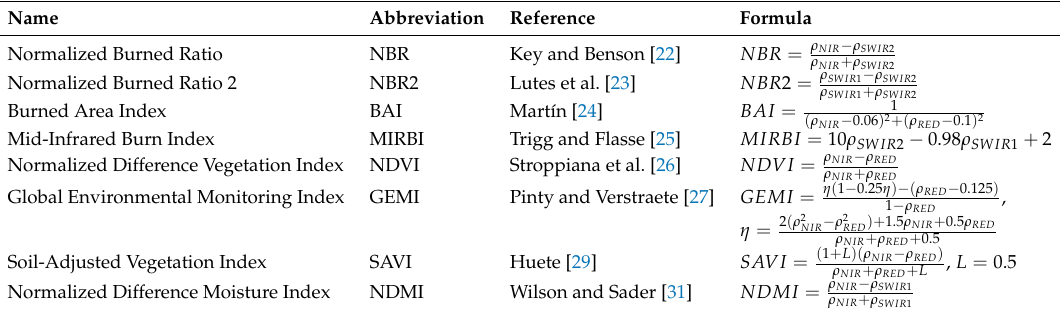
Figure 2. Means and standard deviations of the land surface reflectance of burned and unburned Landsat-8 pixels in different bands. Table 5. The formulas of spectral indices that are sensitive to burned